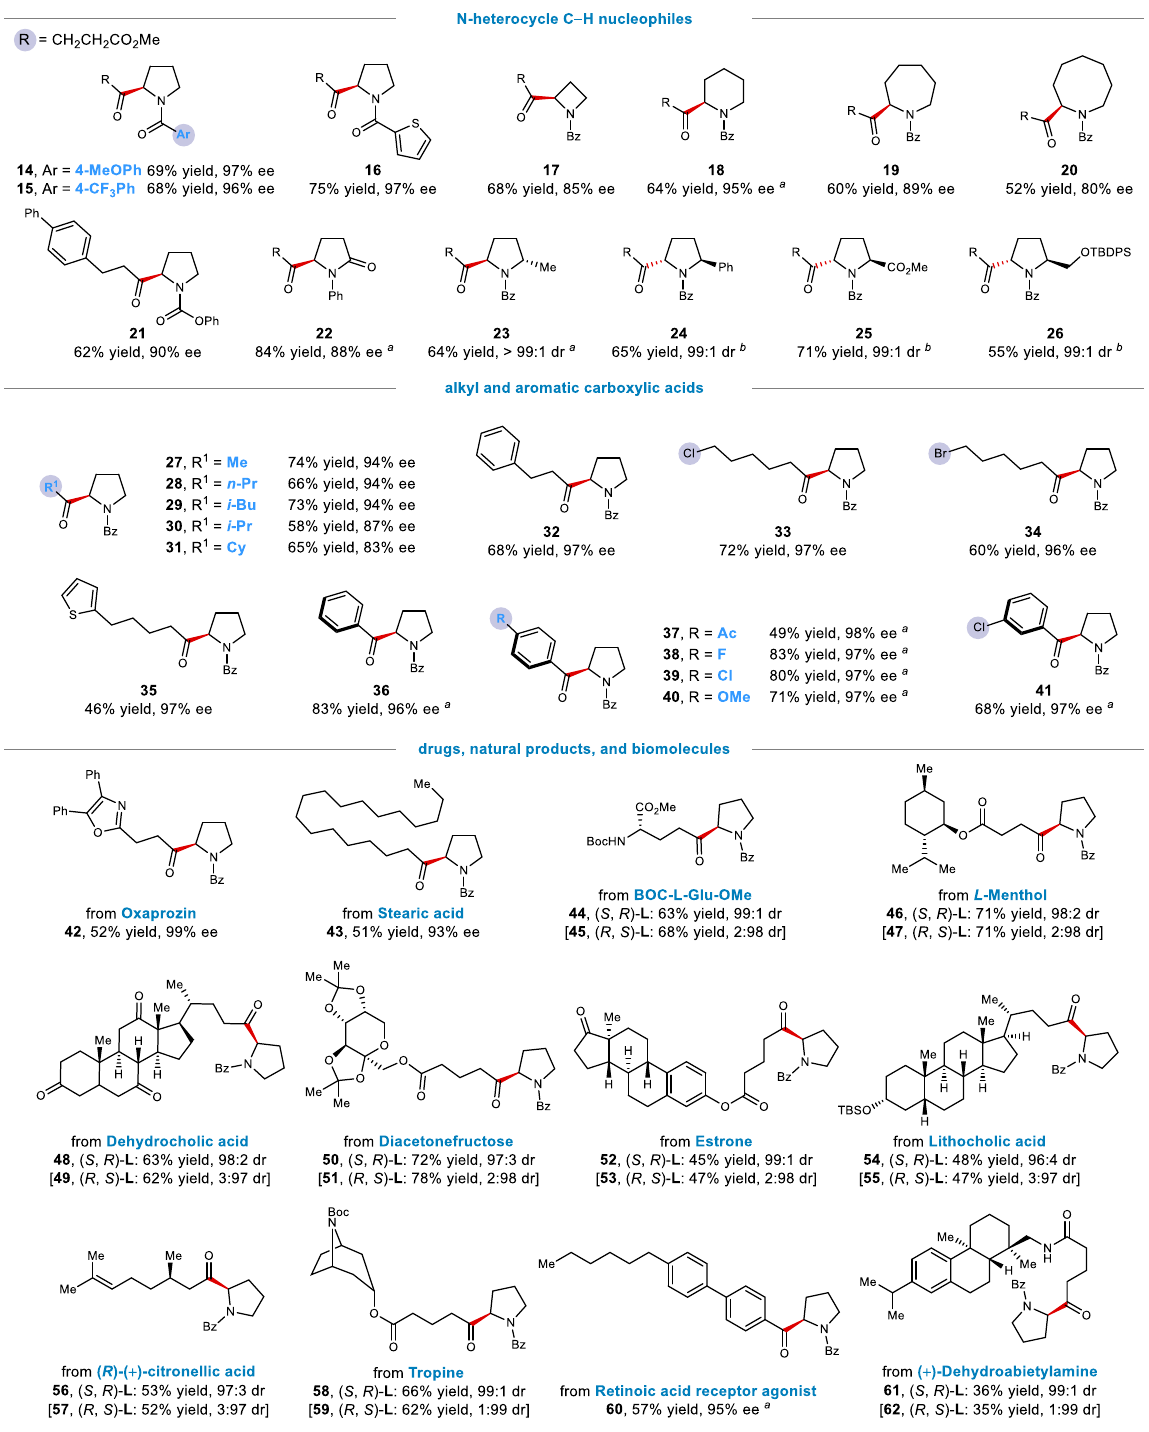
Fig. 3 | Scope of carboxylic acids and saturated azacycles. All data represent the average of two experiments, and all yields are of puri fi ed products. Unless otherwise stated, reactions were conducted on a 0.2mmol scale under standard conditions. a ( S , R )- L2 (13mol%) was used. b ( R , S )- L2 (13mol%) was